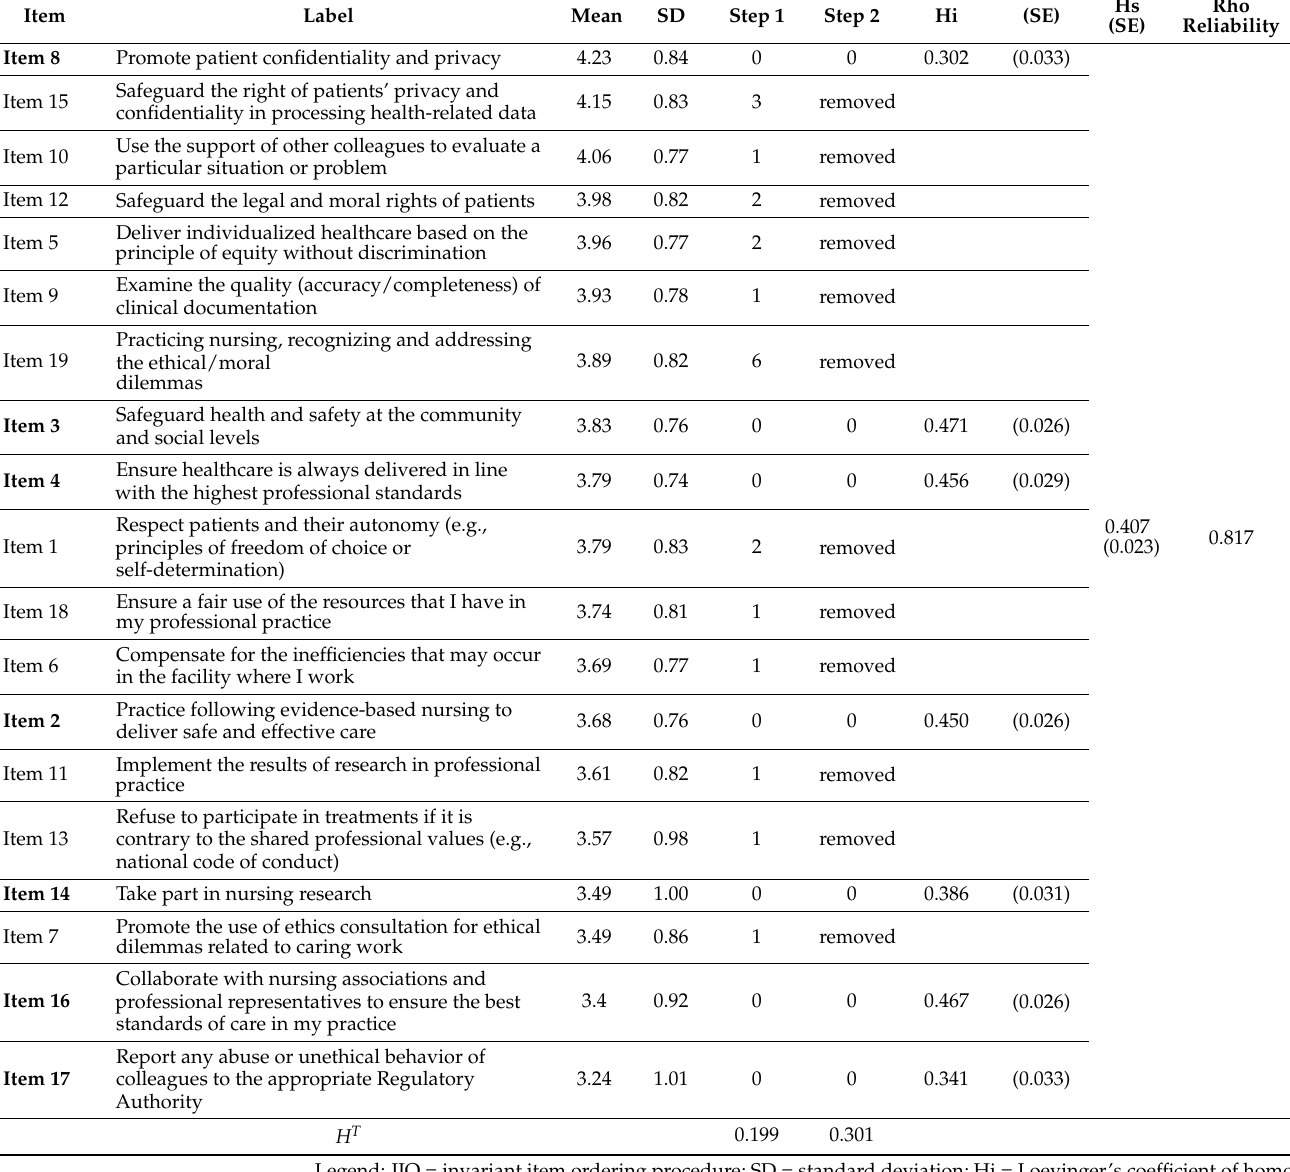
Table 2. Round of IIO and Htrans (HT) per each step and Mokken scale (N =